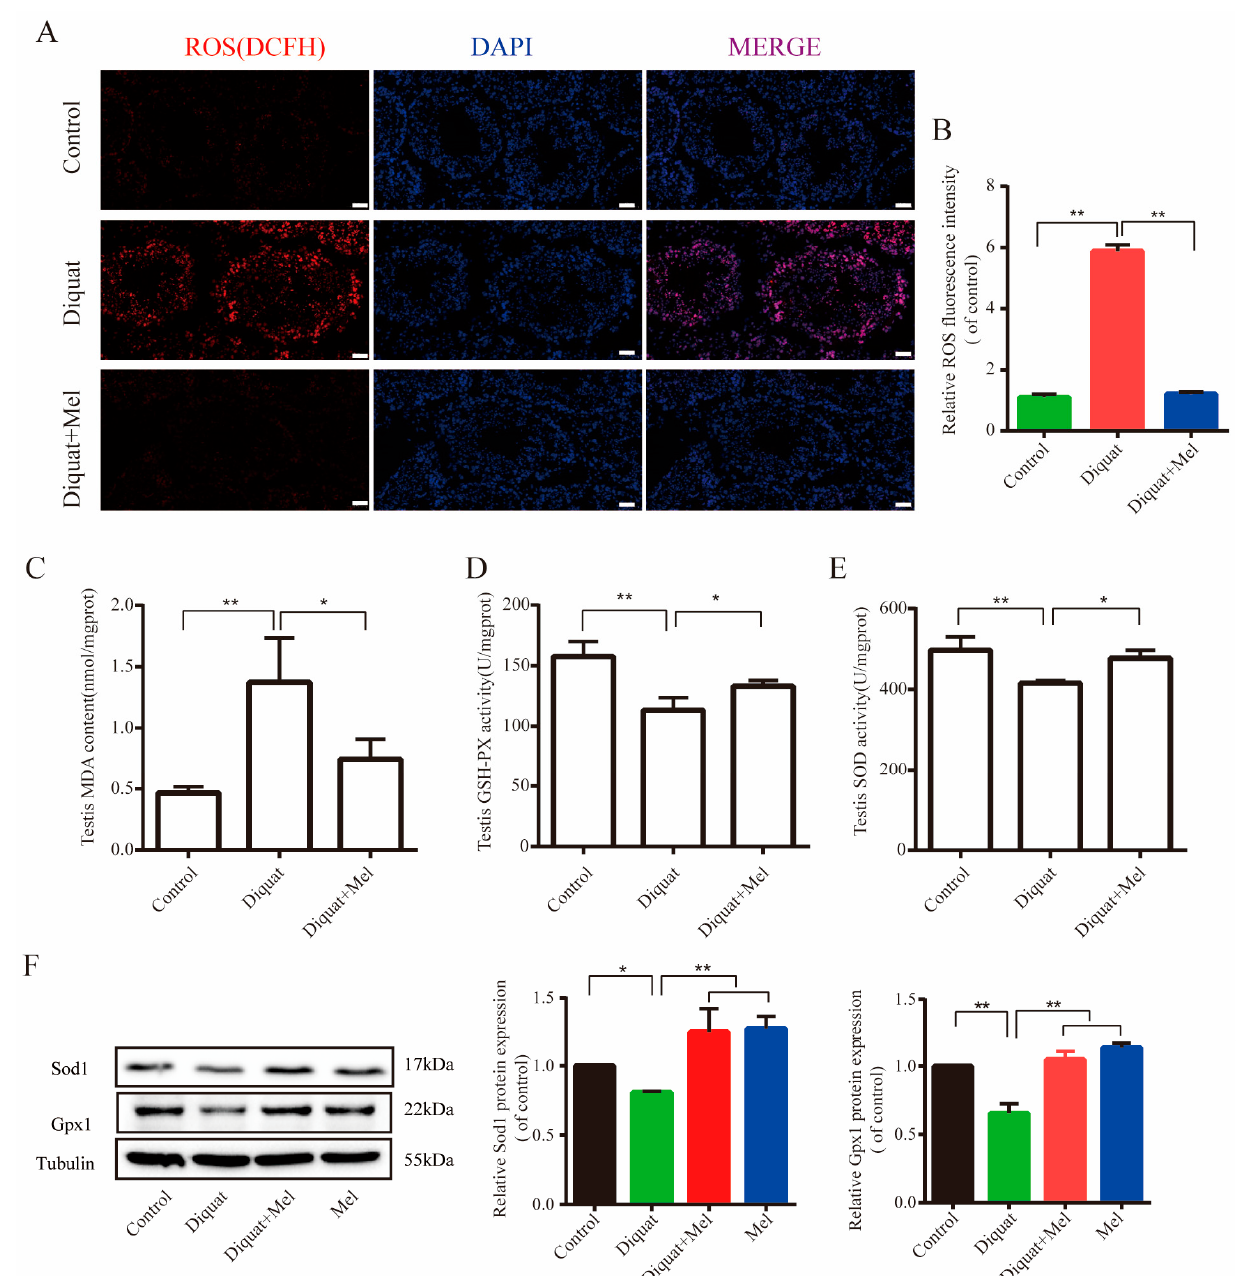
Figure 2. Melatonin protects testis against oxidative stress caused by diquat: ( A ) representative images of ROS levels in the control and diquat treatment with or without melatonin; ( B ) relative fluorescence density of DCFH analyzed using Image J. Scale bars = 10 µ m; ( C – E ) analysis of the parameters for oxidative stress in the differently treated testes; and ( F ) representative Western blotting of the related antioxidant enzymes SOD1 and GPX1 of the control, melatonin (10 mg/kg/d), diquat (10 mg/kg/d), and diquat combined with melatonin-treated groups. Data are presented as the mean ± SEM of at least three independent experiments. * p < 0.05, ** p < 0.01. MDA, malondialdehyde; GSH-PX, glutathione peroxidase; SOD, superoxide